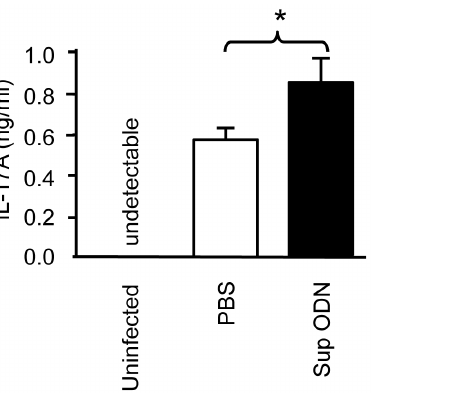
Figure 3. Suppressive ODN improve the Ag-specific Th17 response induced by C.albicans. C57BL/6 mice were challenged with C. albicans and treated with Sup ODN or PBS as described in Fig 2. On day 5, single cell suspensions were prepared from the spleens of these mice and stimulated ex vivo with heat-killed C. albicans for 2 d. Culture supernatants were analyzed for IL-17A levels by ELISA. Data represent the mean + SE of two experiments involving 4–5 indepen- dently studied animals/group. Note that no cytokine was detected in unstimulated cultures or stimulated cultures from uninfected mice. *, p , 0.05 vs PBS.